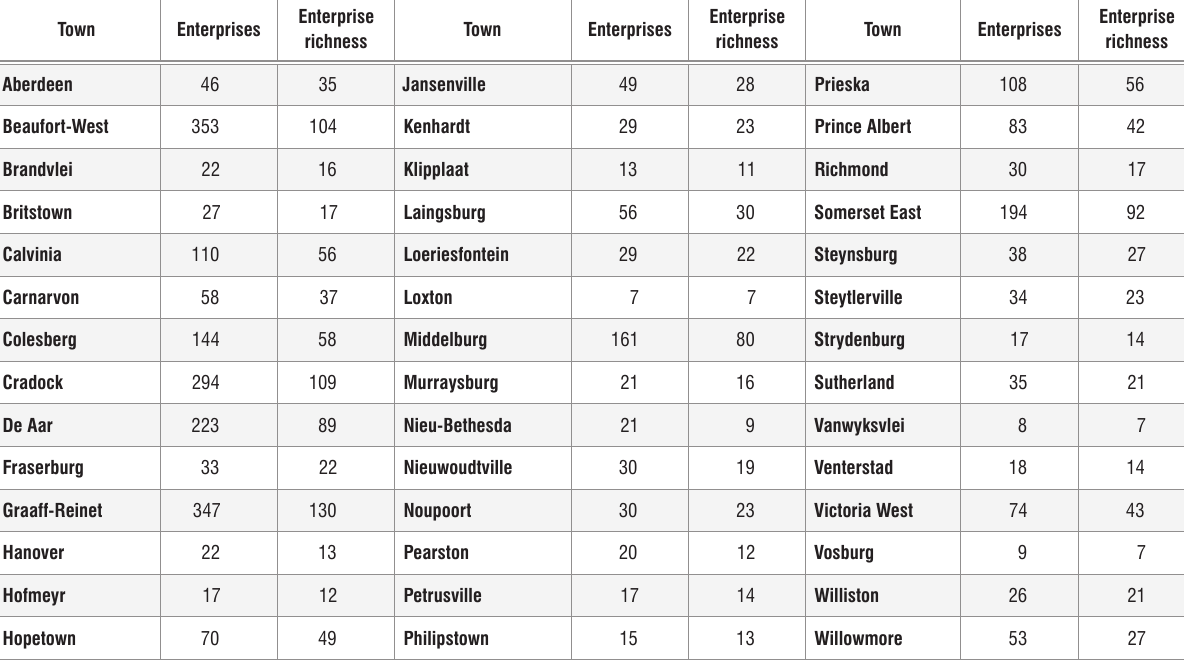
Total number of enterprises and enterprise types (enterprise richness) in 42 Karoo towns 6